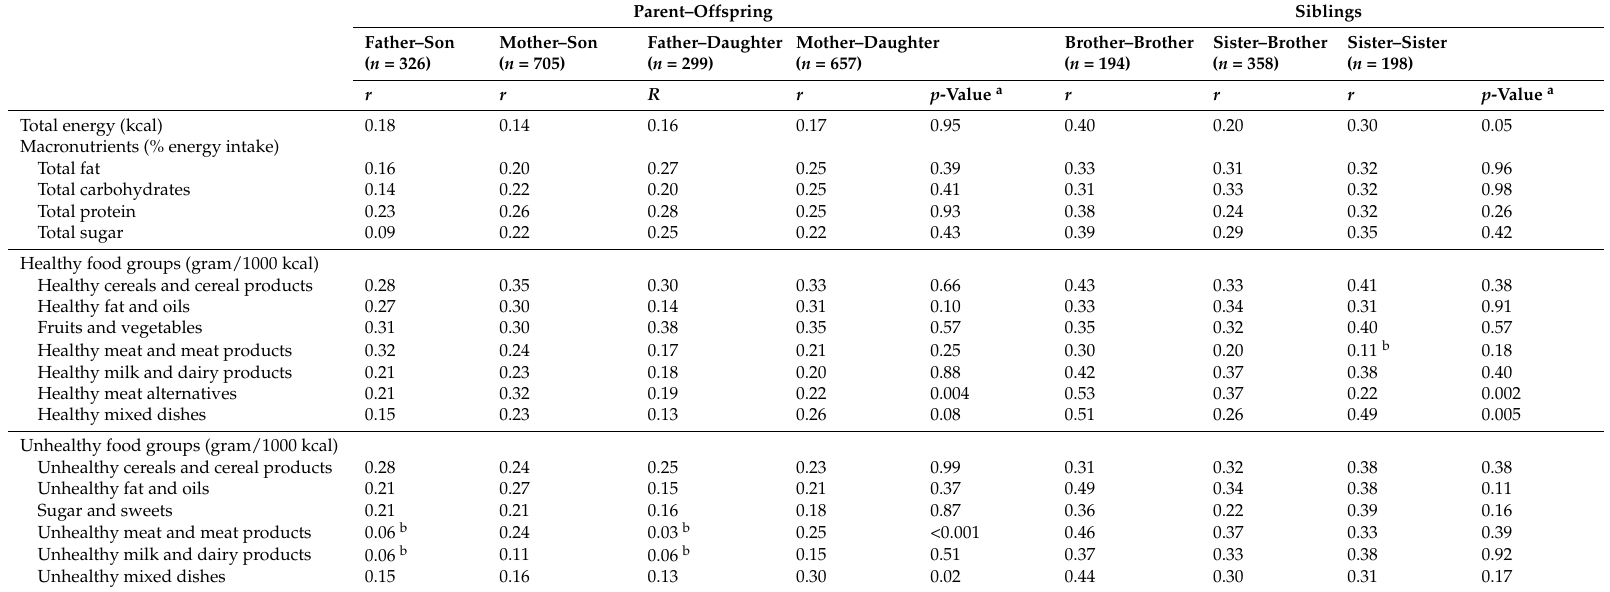
Table 4. Parent–offspring and sibling correlations ( r ) by sex